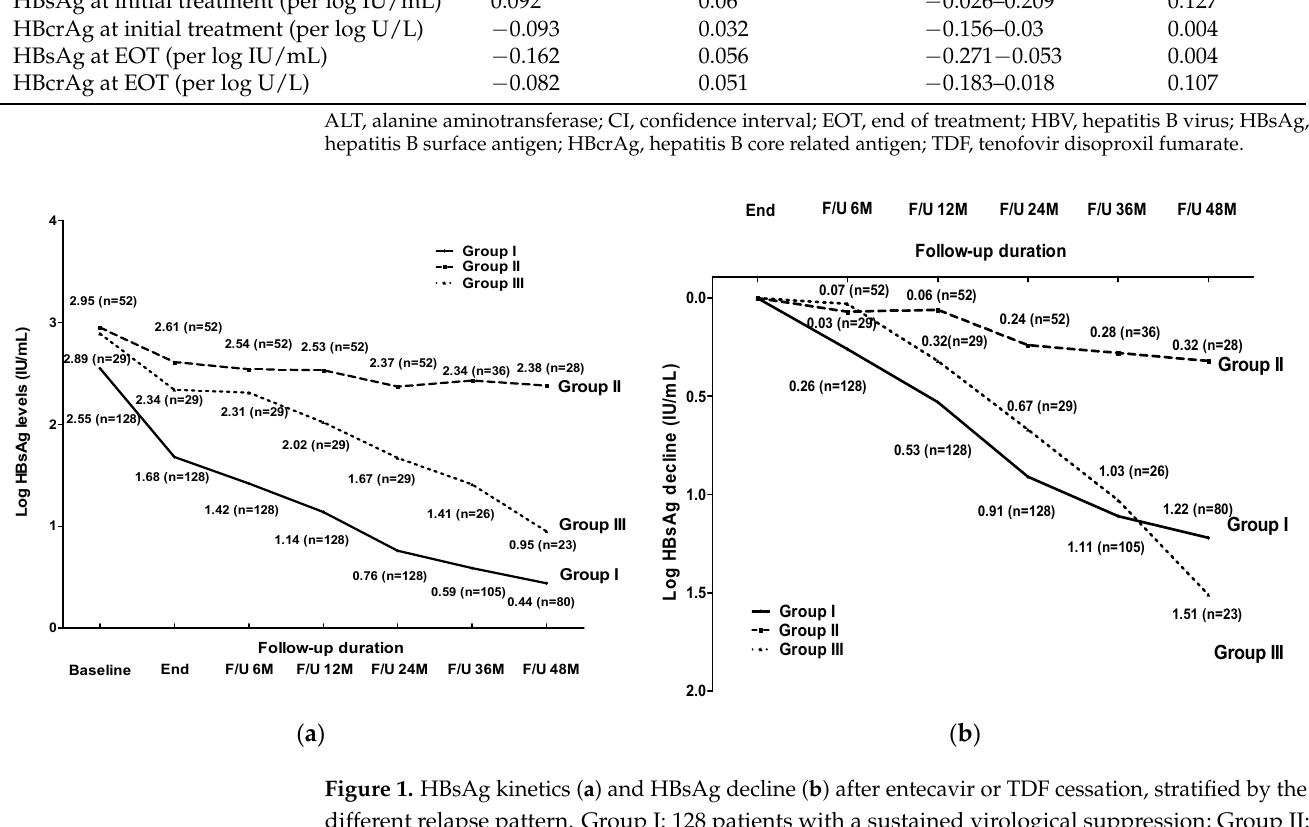
Figure 1. HBsAg kinetics ( a ) and HBsAg decline ( b ) after entecavir or TDF cessation, stratified by the different relapse pattern. Group I: 128 patients with a sustained virological suppression; Group II: 52 patients with persistent or intermittent virological relapse; Group III: 29 patients with a persistent virological suppression after virological relapse.